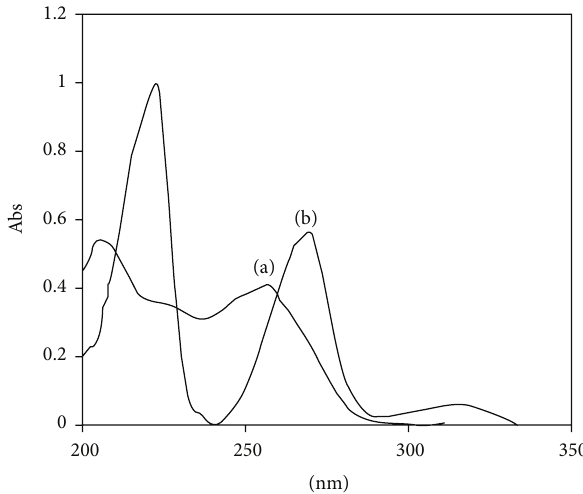
Figure 3: Typical overlaid absorption spectra of (a) OLM and (b)